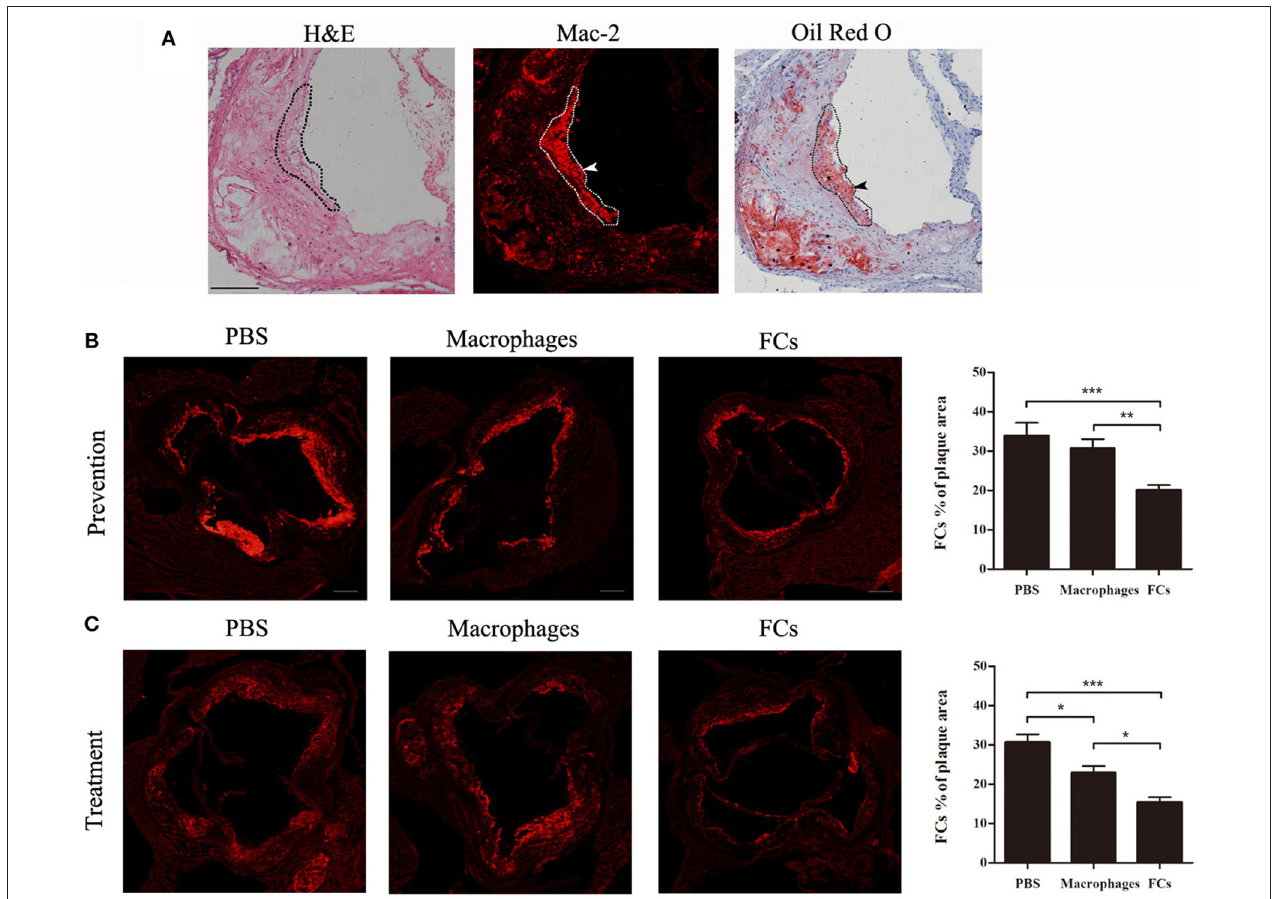
FIGURE 4 | FCs vaccine decreases accumulation of FCs in plaque. (A) Serial cryosections of the aortic root were stained with hematoxylin and eosin, Mac-2, and Oil Red O, and hematoxylin, respectively. Representative photographs of corresponding staining were shown with co-location of Mac-2 and Oil Red O positive area outlined and FCs depicted by arrows. Scale bars, 100 µ m. The FCs content in the aortic root of initial (B) and advanced (C) plaque were evaluated as the Mac-2 positive area per plaque area. Scale bars, 200 µ m. * p < 0.05; ** p < 0.01; *** p <